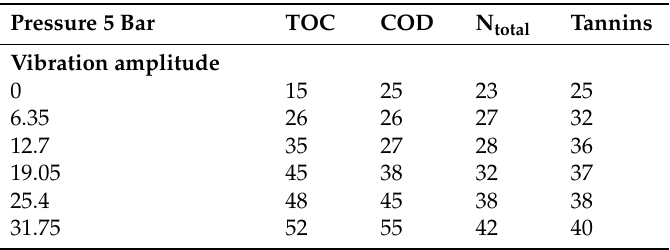
Table 2. Removal (%) of major pollution parameters (total organic carbon (TOC), chemical oxygen demand (COD), N total and tannins), when the microfiltration (MF) process was applied for the treatment of simulated tannery wastewaters.